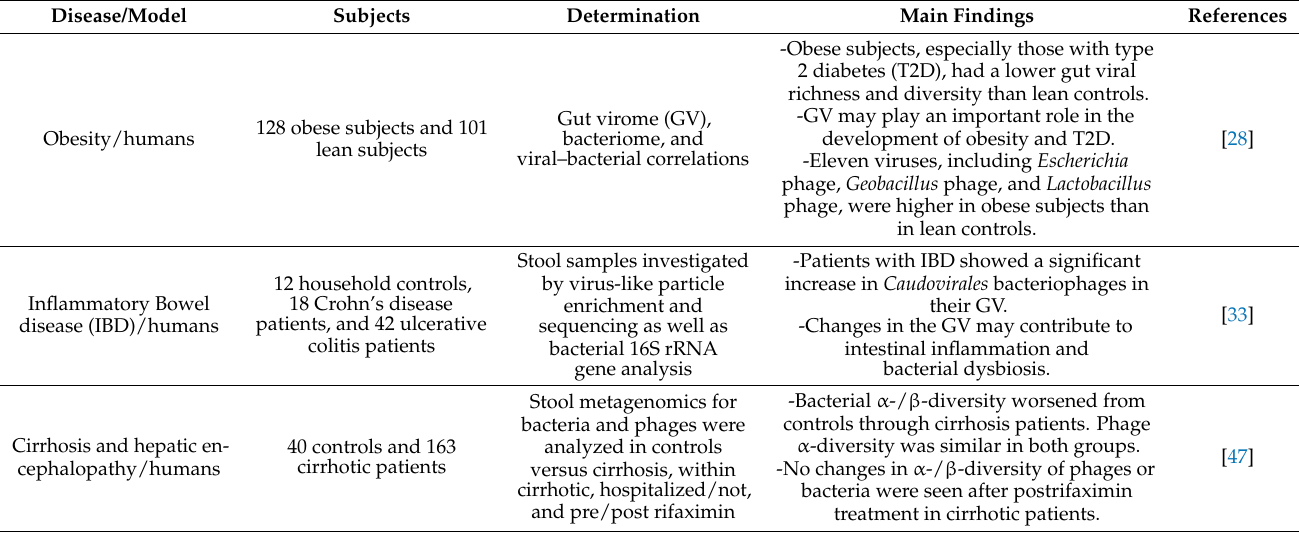
Research works investigating the relationship between the gut virome and metabolic